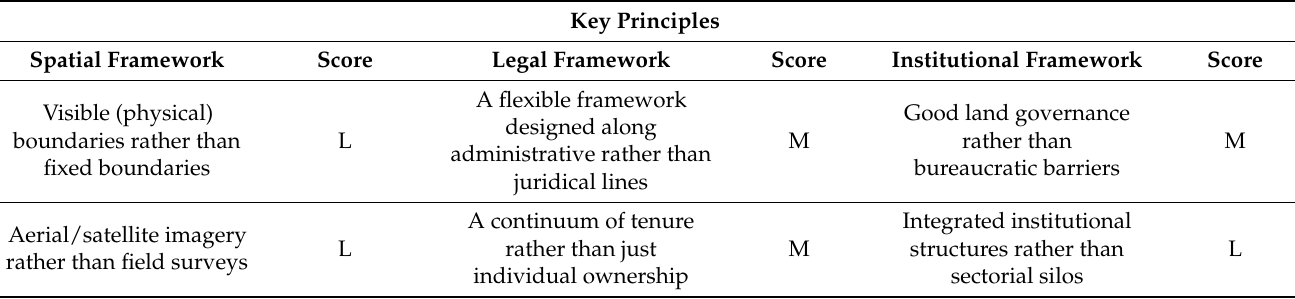
Table 3. A score table based on the assessment of the fit-for-purpose land administration for Ecuador. Key